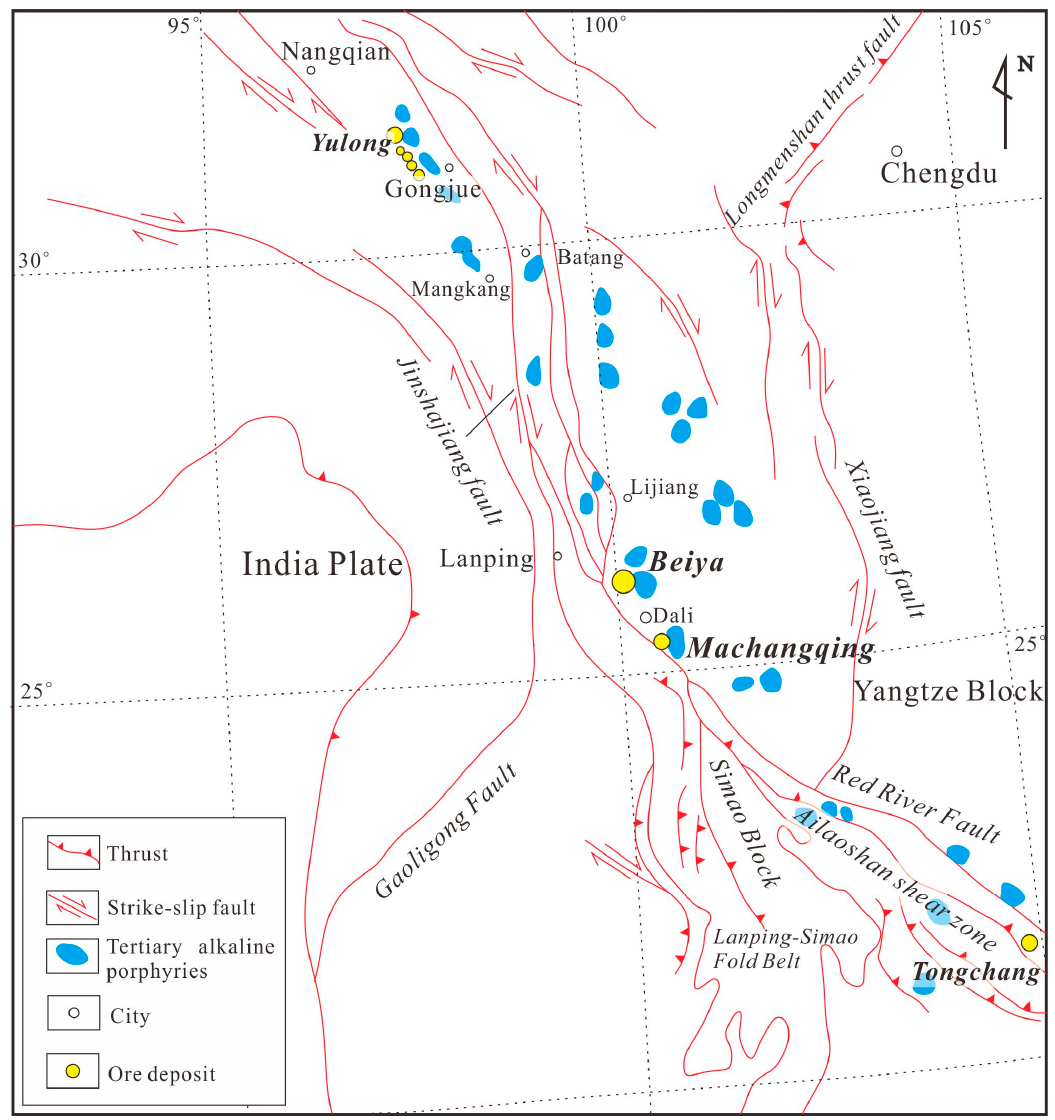
Figure 1. Tectonic map of the Beiya and Machangqing deposit. Modified after [41,42].